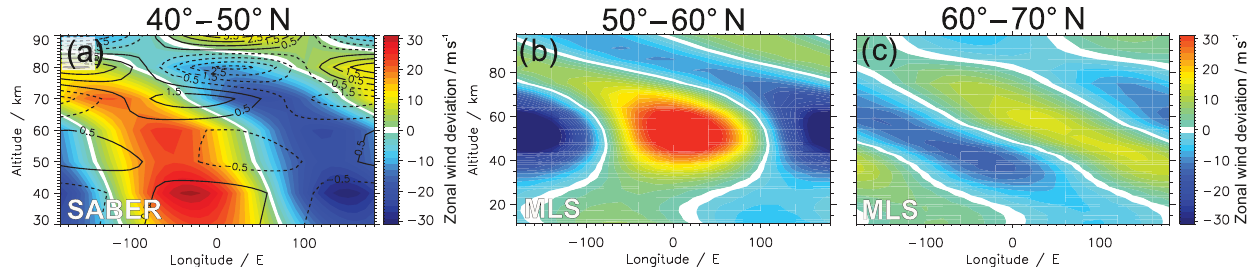
Figure 7. (a) Longitude–altitude cross sections of the wavenumber 1 filtered geostrophic zonal wind amplitude (colored contour) and the absolute GW drag amplitude in ms − 1 day − 1 (contour lines) in Period I averaged between 40 and 50 ◦ N and derived from SABER data. (b) and (c) Longitude–altitude cross sections of the wavenumber 1 filtered geostrophic zonal wind amplitude in Period I averaged between 50 and 60 ◦ N and 60 and 70 ◦ N, respectively. Data are derived from MLS GPH data.